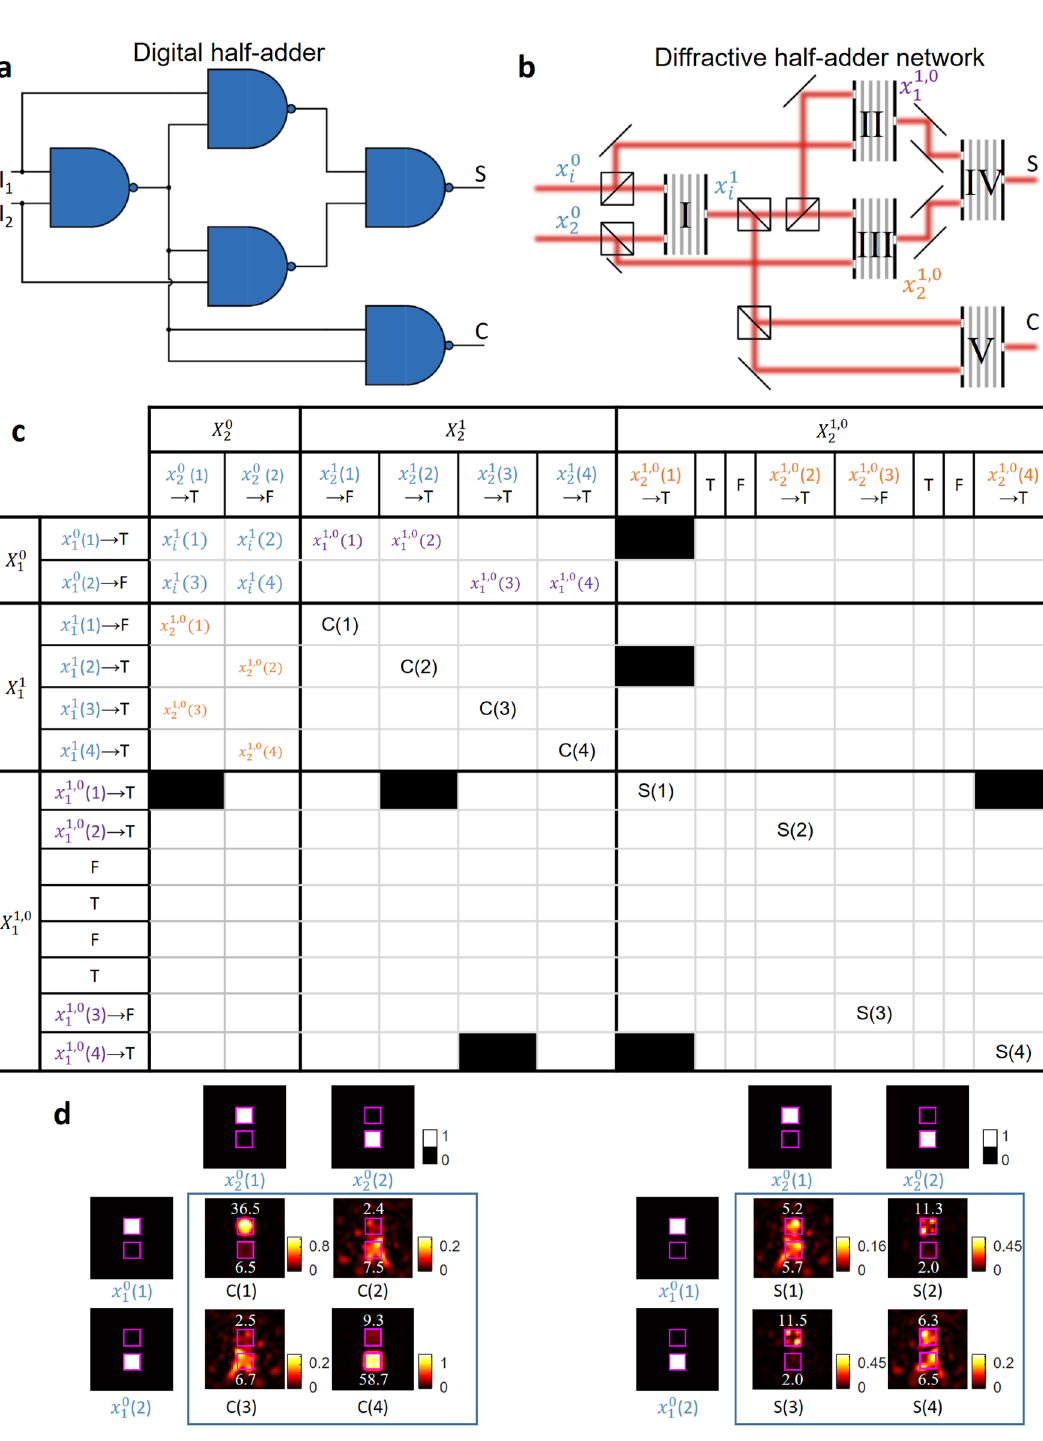
Figure 5. A half-adder that is composed of cascaded diffractive NAND gates. ( a ) Digital implementation of a half-adder using NAND gates. ( b ) An all-optical half-adder composed of cascaded diffractive NAND gates. ( c ) The correctness of the intermediate all-optical calculation steps ( x 1 i ) and the sum (S) and carry (C) of the half- adder using different input combinations. ( d ) The intensity profiles at the output plane of the diffractive NAND IV (representing the sum) and the diffractive NAND V (representing the carry) gates. The inserted numbers in white font color indicate the relative optical signal within each aperture. Each input optical logical value is assumed to have a relative optical signal level of 1024 (a.u.), defining the ideal signal level per